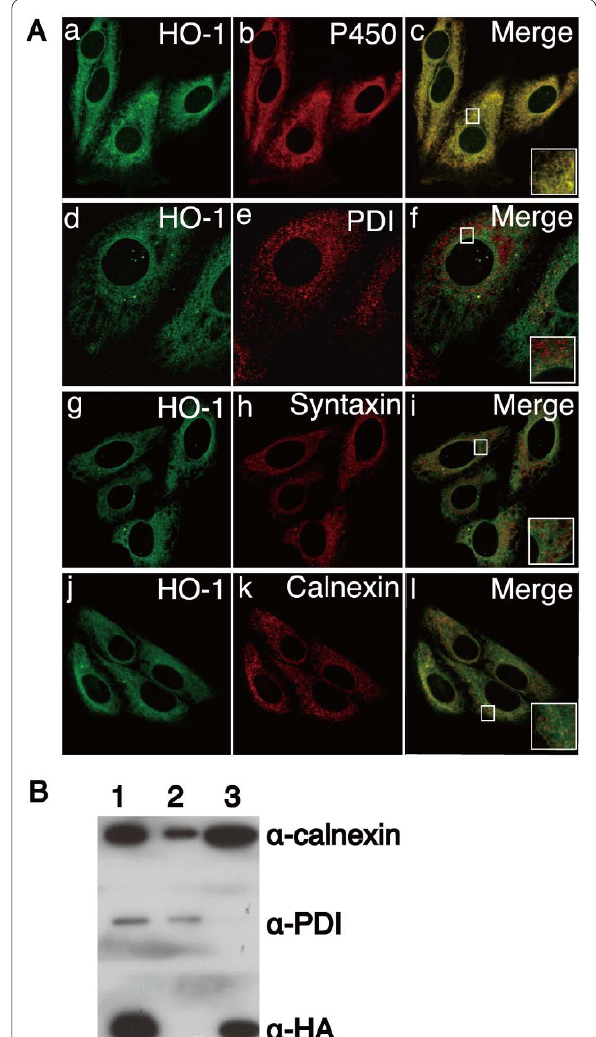
Figure 1 HOs are localized to smooth ER . A. GFP-tagged HO-1 was cotransfected with mCherry-tagged NADPH-cytochrome P450 re- ductase or mCherry-tagged syntaxin 17 into HEp-2 cells and visualized by confocal microscopy. Cells were fixed and incubated with antibod- ies against GFP (a, d, g, and j), mCherry (b and h), PDI (e), and calnexin (k). Each inset shows a higher magnification image of the boxed area. B. Separation of rough and smooth microsomes. The subcellular frac- tionation method is described in detail in the Methods section. Pro- teins were detected by anti-HA, anti-PDI, and anti-calnexin mAbs. Lane 1, post mitochondrial supernatant; lane 2, rough microsomal fraction; lane 3, smooth microsomal fraction. Similar results were obtained in 3 independent